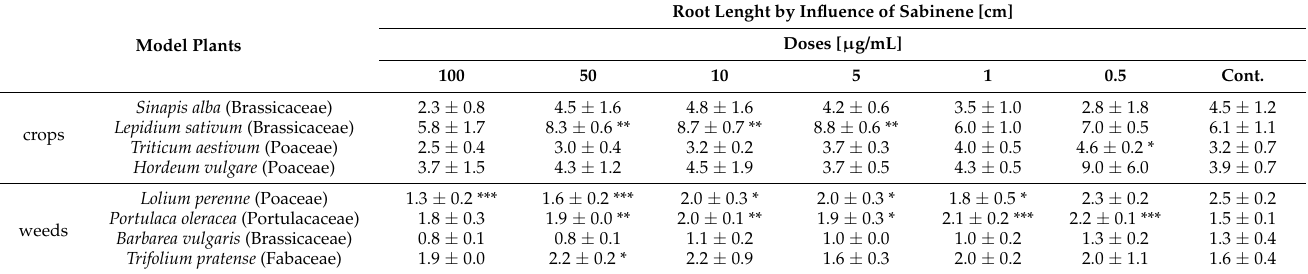
Table 5. Root length (cm) after 120 h from the application of several doses of sabinene EO. Results are reported as the mean ± SD of six experiments.